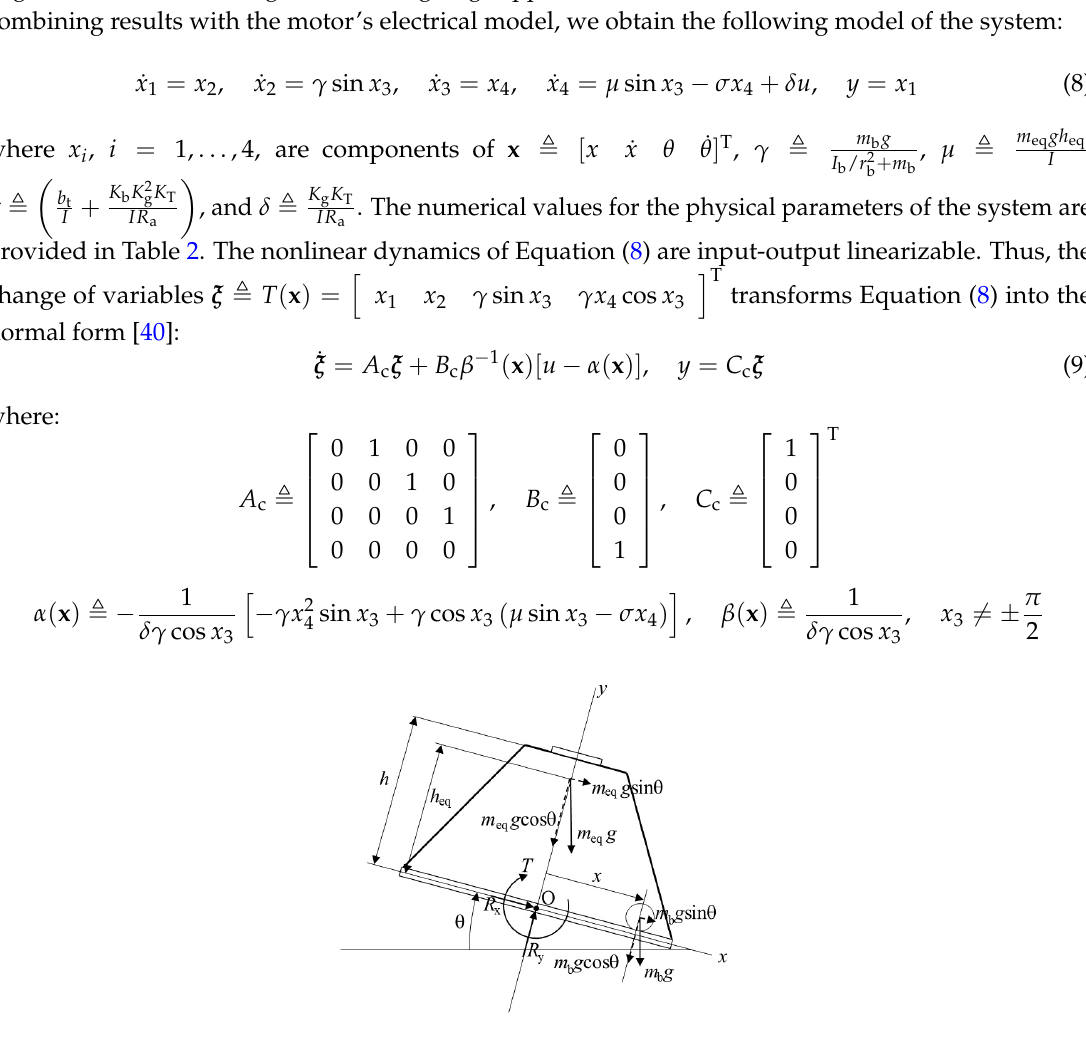
Figure 8. Free-body diagram of the smartphone-mounted ball and beam